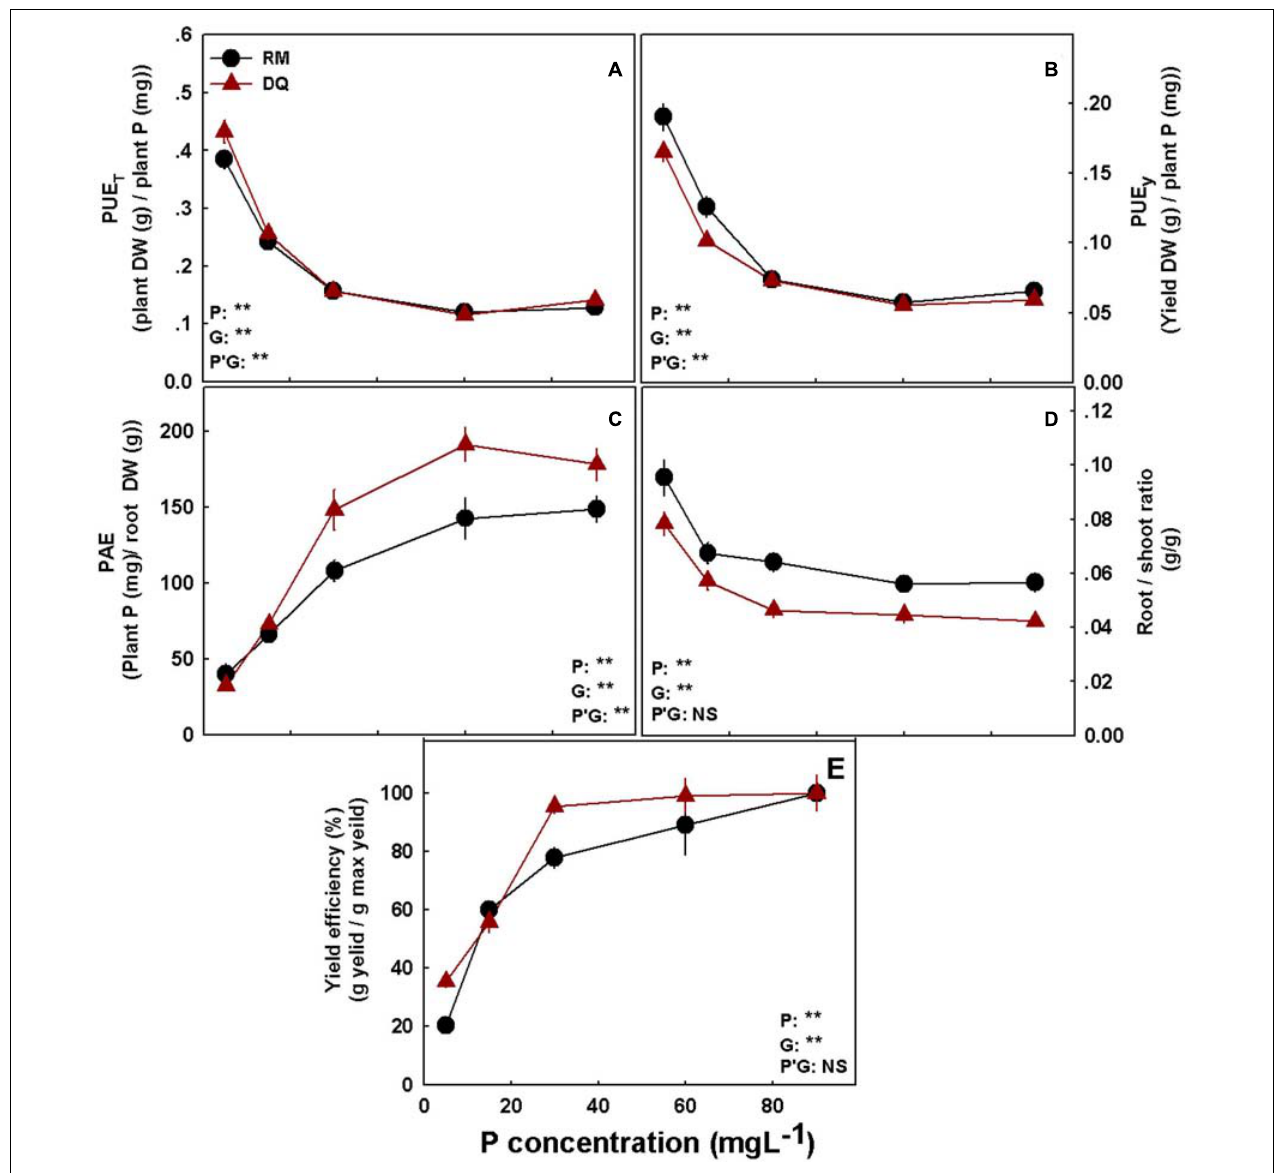
FIGURE 8 | Phosphorus efficiency parameters for two medical cannabis cultivars RM (A) and DQ (B) . P utilization efficiency for total dry weight (A) , P utilization efficiency for yield dry weight (B) , phosphorus acquisition efficiency (C) , Root/shoot ratio (D) , and yield efficiency (E) . Presented data are averages ± SD ( n = 5). Results of two-way ANOVA indicated as ** P < 0.05, F -test; NS, not significant P > 0.05, F -test. In the ANOVA results, P*G, the interaction between P and